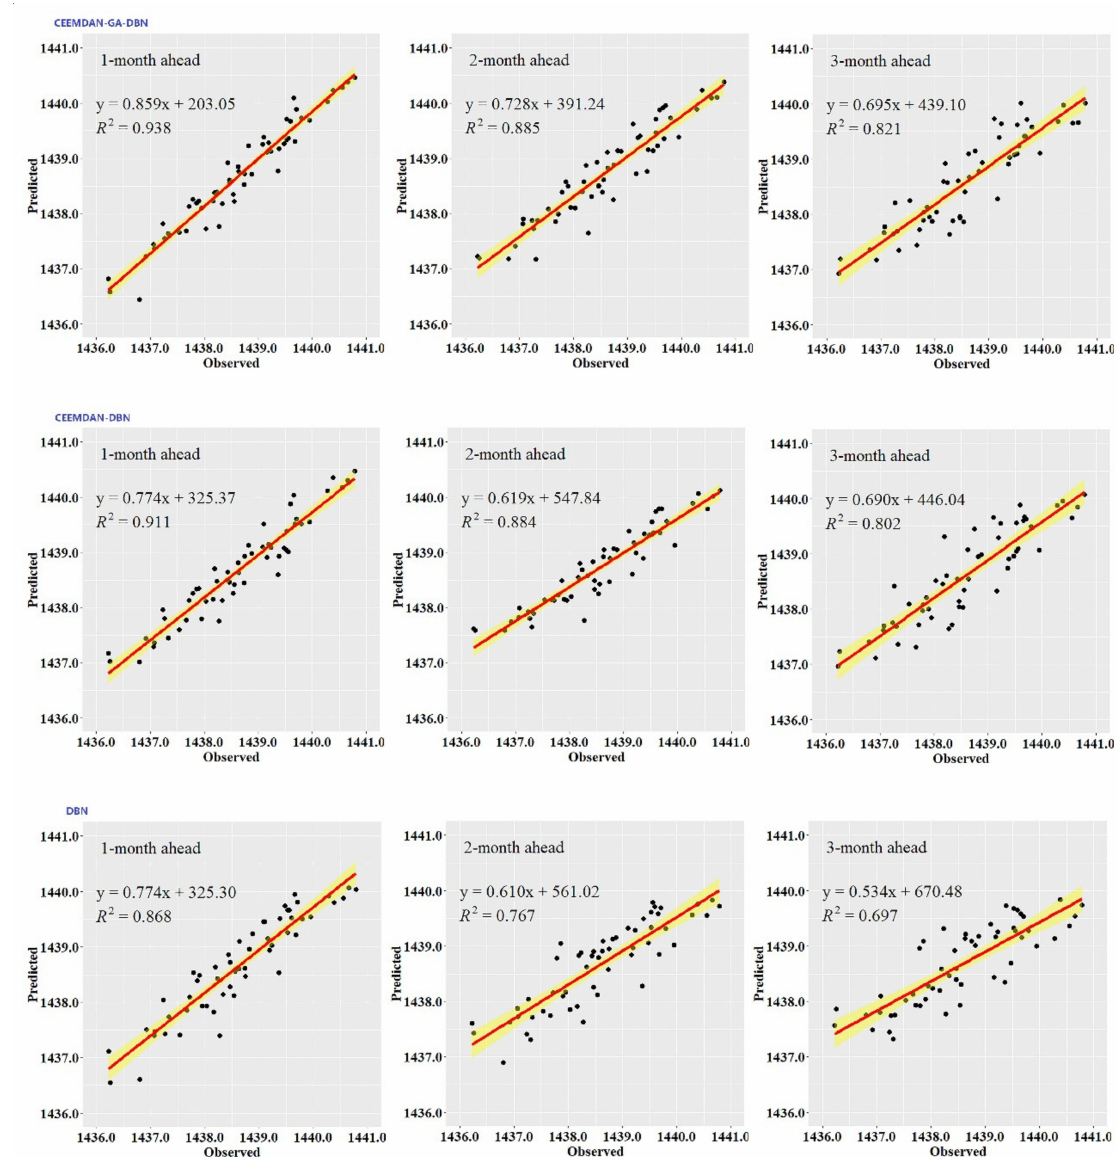
Figure 6. Scatter plot of the observed and predicted groundwater level for Well II generated by the CEEMDAN-GA-DBN, CEEMDAN-DBN and DBN models for 1-, 2- and 3-month ahead forecast in the testing period.